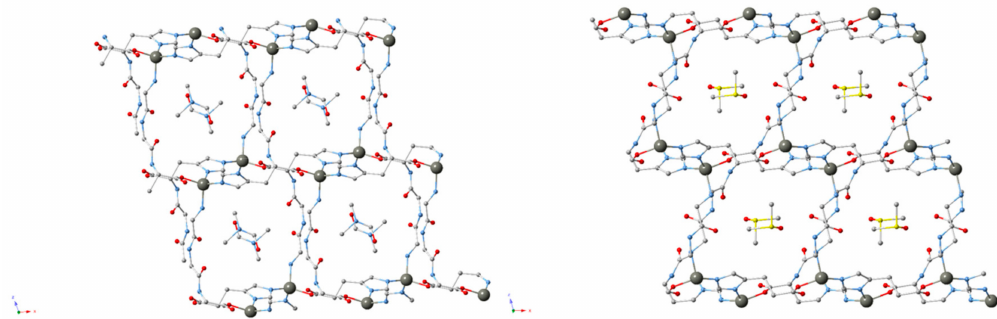
Figure 16. MOFs consisting of the tripeptide glycine–glycine–l-histidine (GGH), Zn and di ff erent solvents (clockwise, upper left to lower left: ZnGGH-1, -9, -2 and -3)